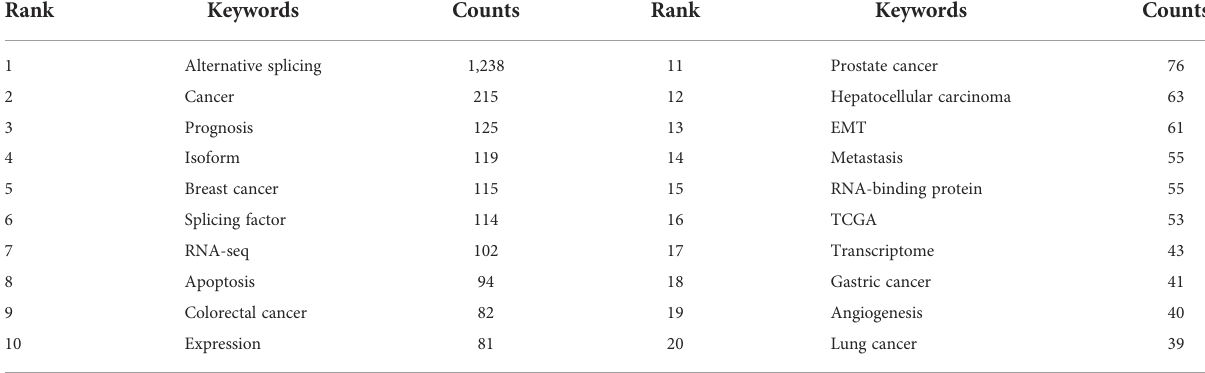
TABLE 5 Top 20 keywords related to alternative splicing of cancer.